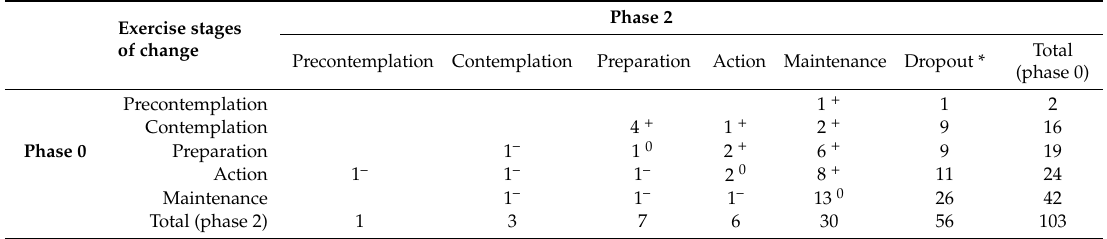
Table 3. Exercise stages of change in phase 0 (pre-intervention) and phase 2 (post-intervention).